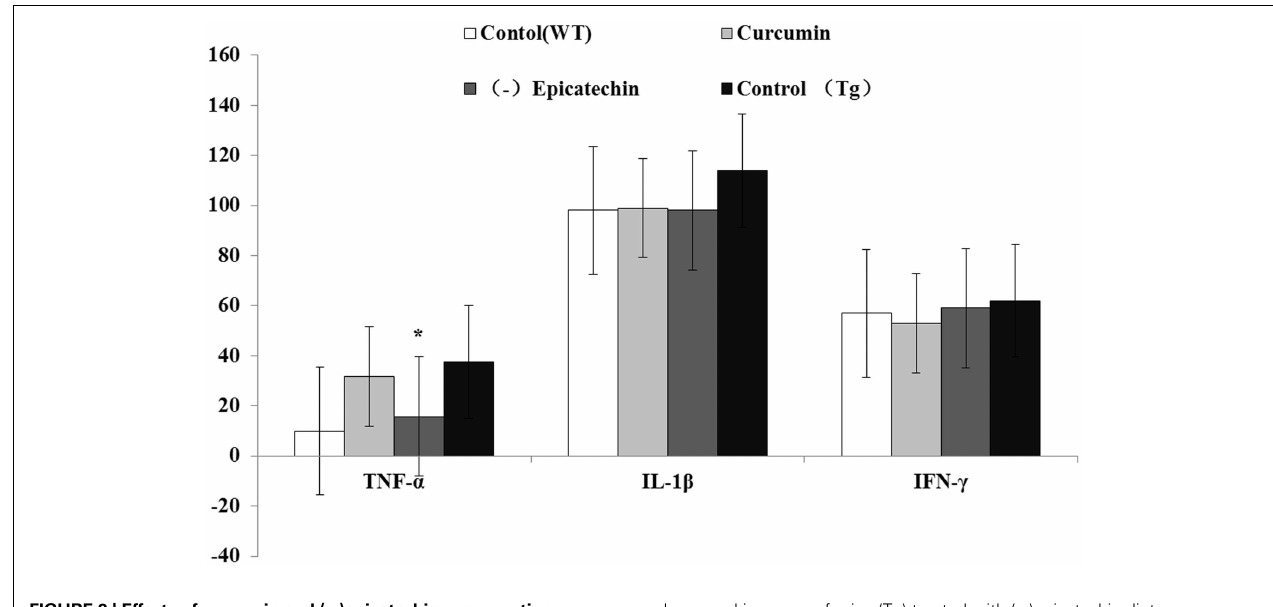
FIGURE 8 | Effects of curcumin and ( − )epicatechin consumption on plasma levels ofTNF-a, IL-1 β , and IFN- γ . Levels ofTNF-a, IL-1 β , and IFN- γ in serum were measured using ELISA kits (eBioscience). Statistical analysis showed the level ofTNF- α was significantly